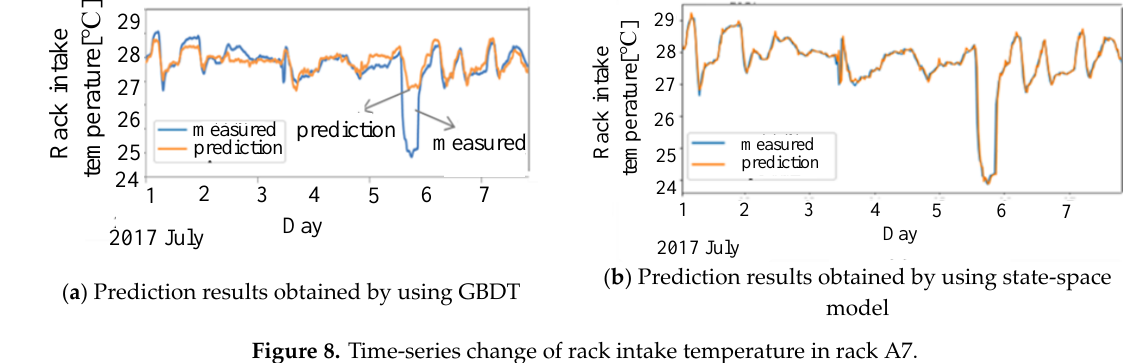
Figure 7. Comparison of measured rack intake temperature in rack A1 and temperatures predicted by prediction model using GBDT and state-space model.